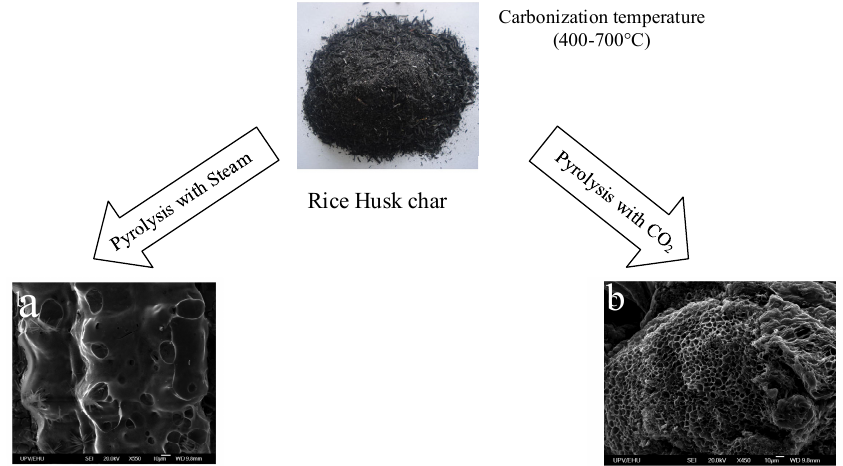
Figure 3. Physical activation of RH. ( a ) SEM image of RH-derived AC with steam; ( b ) SEM image of RH-derived AC with CO 2 . Reproduced with permission from [81]; Copyright © 2015, American Chemical Society.